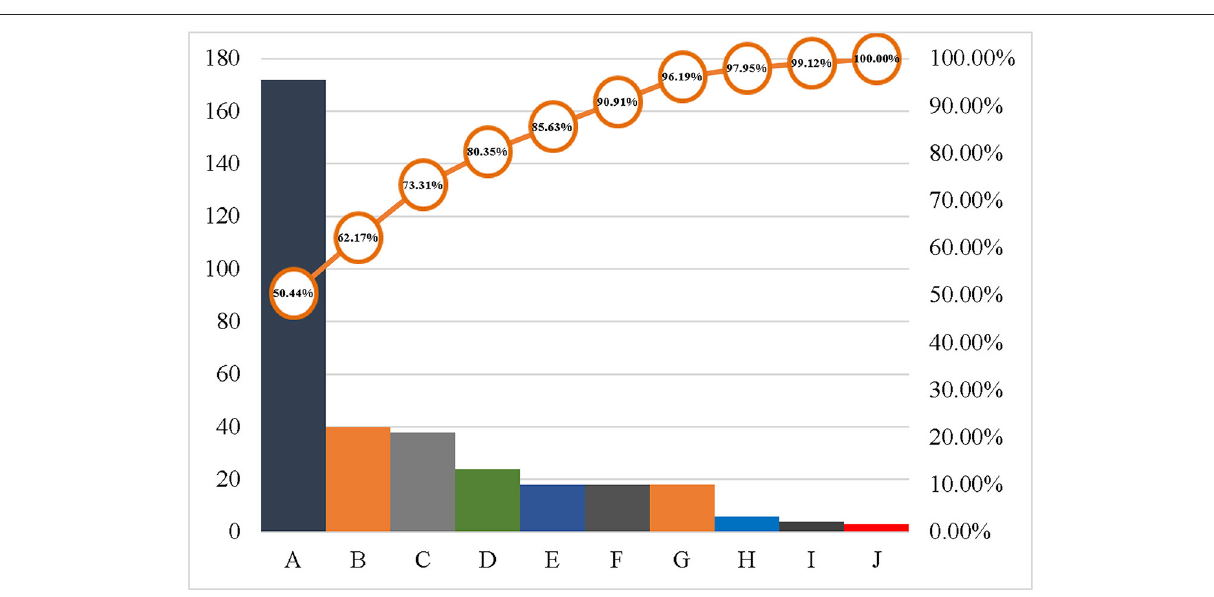
FIGURE 2 | Causes of hospital